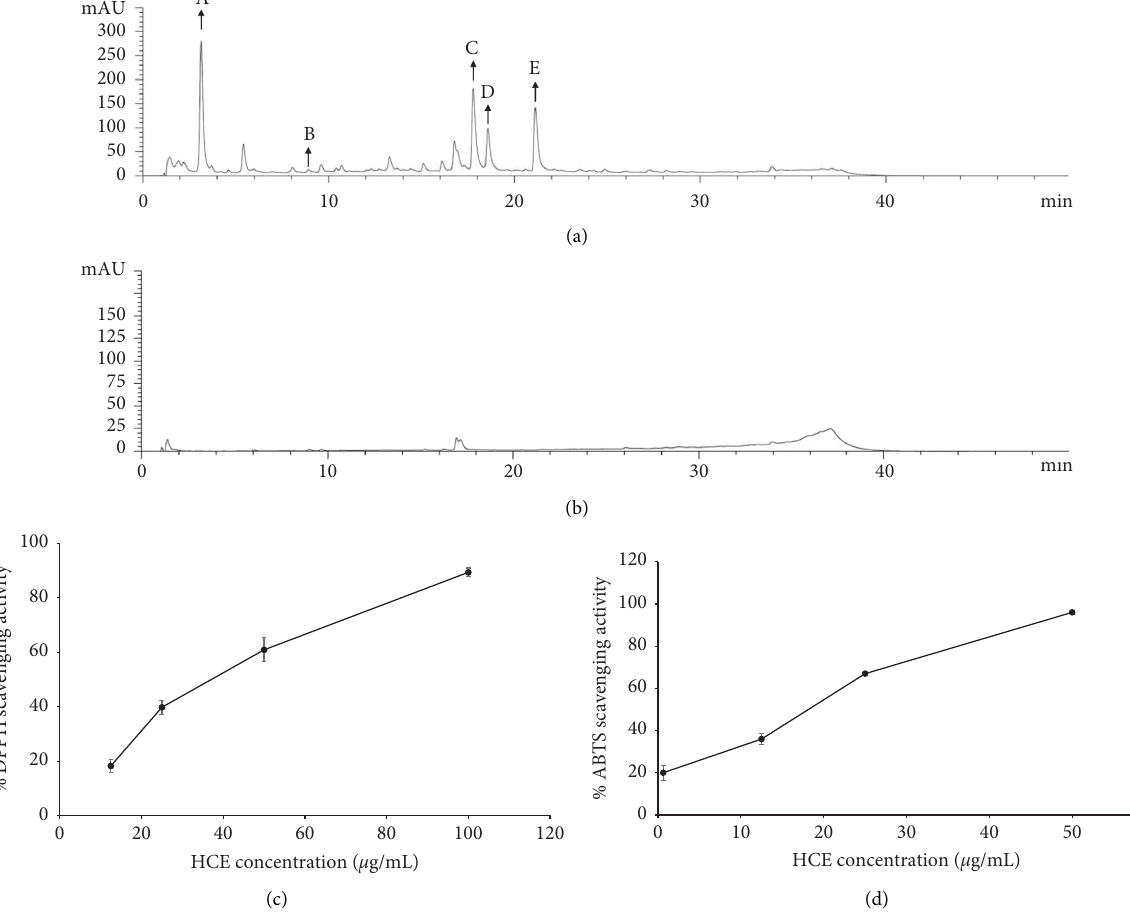
Figure 7: HPLC chromatogram of HC extract. (a) HCE. “A” stands for gallic acid; “B” stands for chlorogenic acid; “C” stands for rutin; “D” stands for rosmarinic acid; “E” stands for quercetin. (b) HCW. The percentage of antioxidant of HCE against (c) DPPH and (d) ABTS free radicals. The results represent mean ± SD of triplicate independent experiments, and each point was significantly different ( p < 0 .